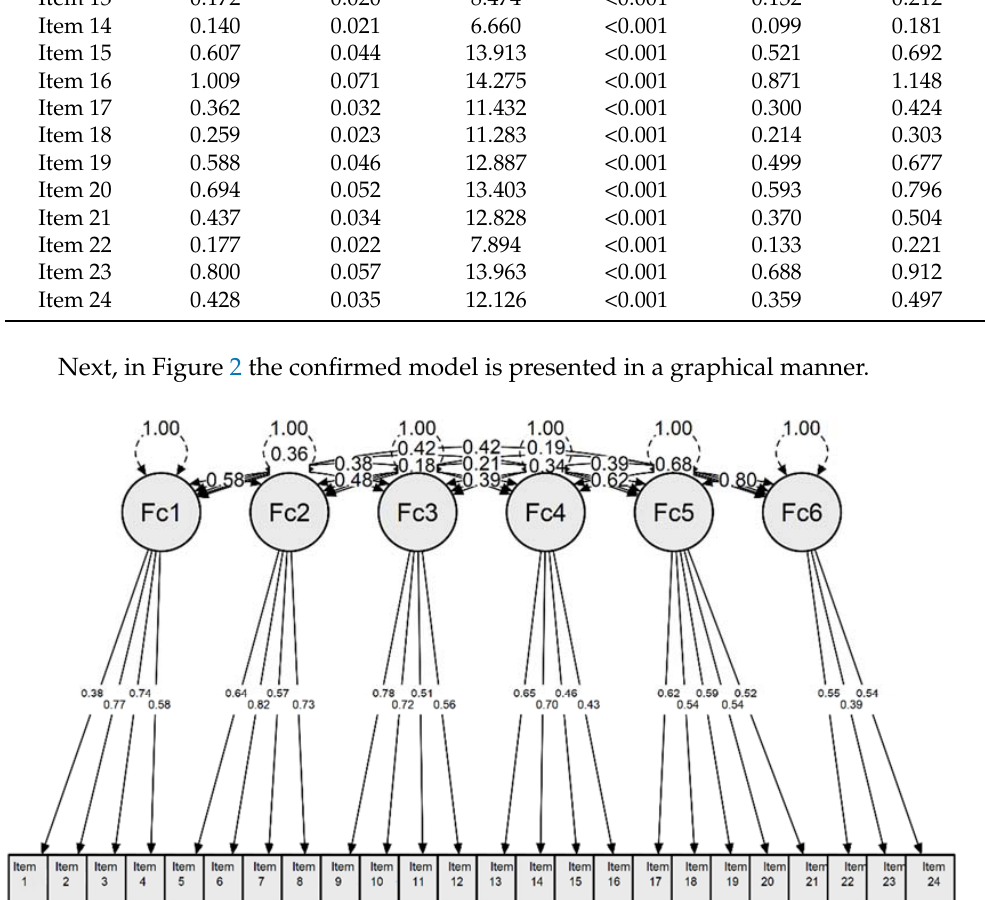
Table 6. Residual variances.